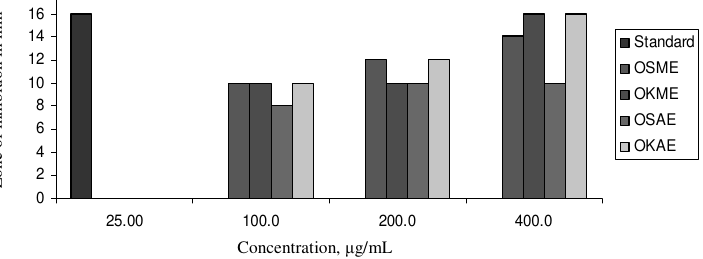
Figure 4. Antifungal activity of Ocimum extracts against C.